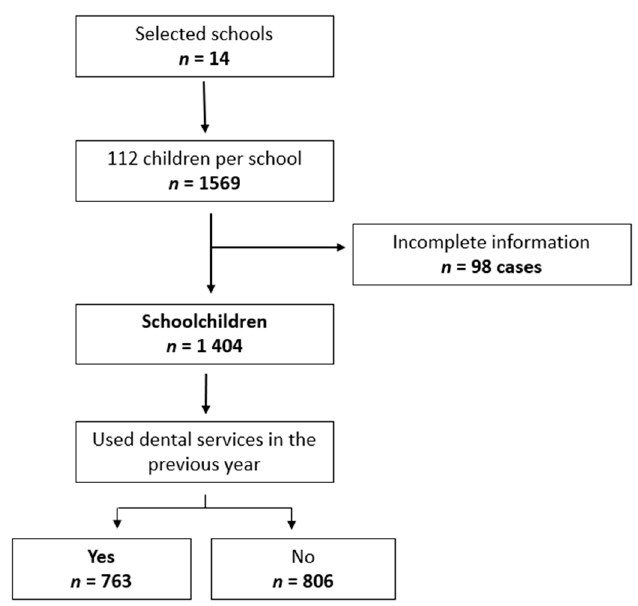
Figure 1. Selection of the sample of schoolchildren from participating schools, Pachuca, Mexico.